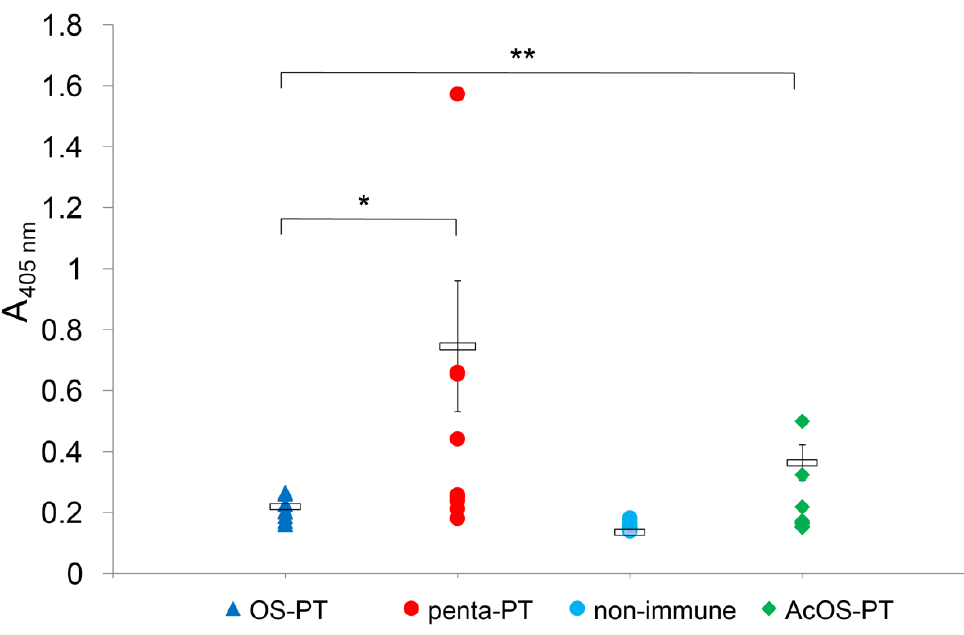
Figure 3. Anti- B. pertussis 186 LOS IgG levels in sera of mice immunized with OS-PT, penta-PT and AcOS-PT conjugates in ELISA Sera were obtained from the immunization number V (for details on all the prior immunizations see Figure S3). Non-immune sera were used as a control. Each serum was 50-fold diluted and read out using B. pertussis 186 LOS as a solid phase in ELISA. Each individual symbol corresponds to a single mouse serum. Horizontal bars indicate arithmetic mean of IgG titers for each group. Differences between group titers as compared to these of non-immune sera were significant at p < 0.05. Significant differences were also noted between the OS-PT and penta-PT (*, p = 0.032) as well as OS-PT and AcOS-PT (**, p = 0.039 Abbreviations: OS-PT—conjugate of B. pertussis 186 OS and pertussis toxin (PT), penta-PT—conjugate of the pentasaccharide derived from B. pertussis 186 with pertussis toxin, AcOS-PT –conjugate of the N-acetylated B. pertussis 186 OS and pertussis toxin, OVAp—ovalbumin peptide.